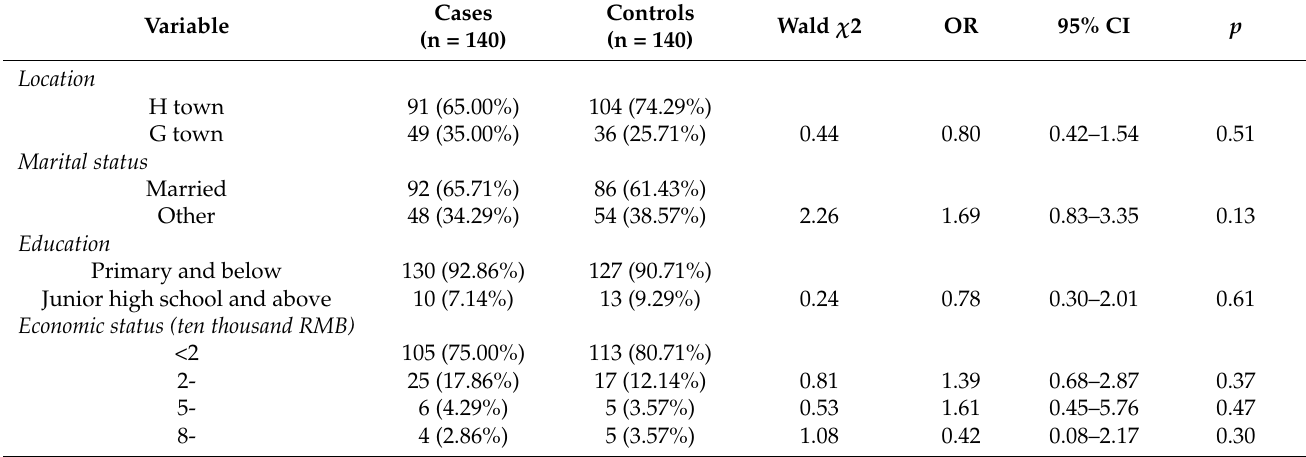
Table 5. Univariate analysis of baseline information in CVDs